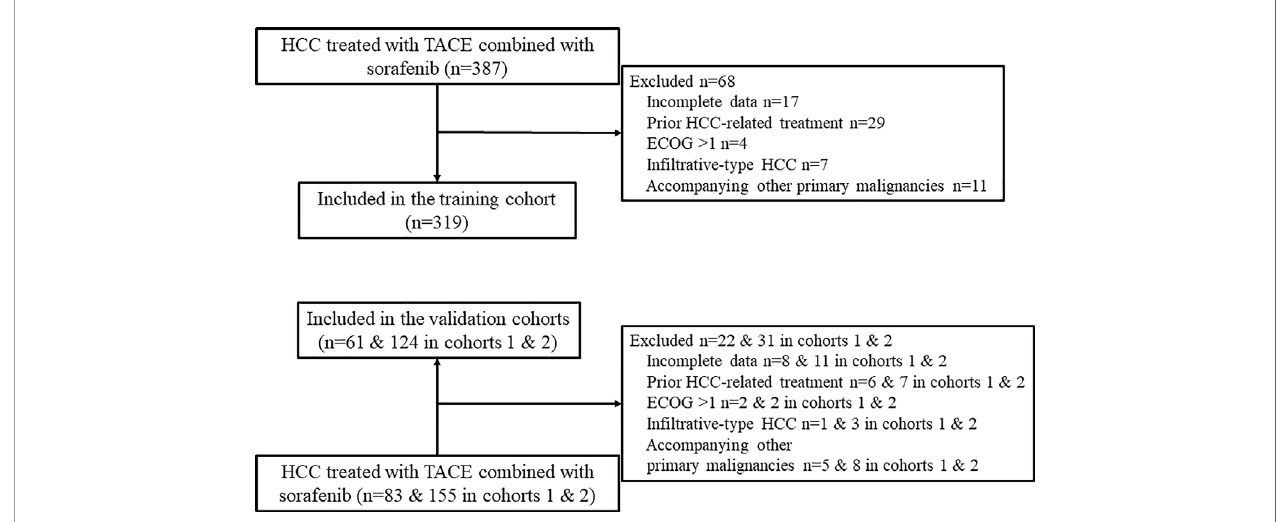
FIGURE 1 | Flow chart of patient selection. HCC, hepatocellular carcinoma; TACE, transarterial chemoembolization; ECOG, Eastern Cooperative Oncology